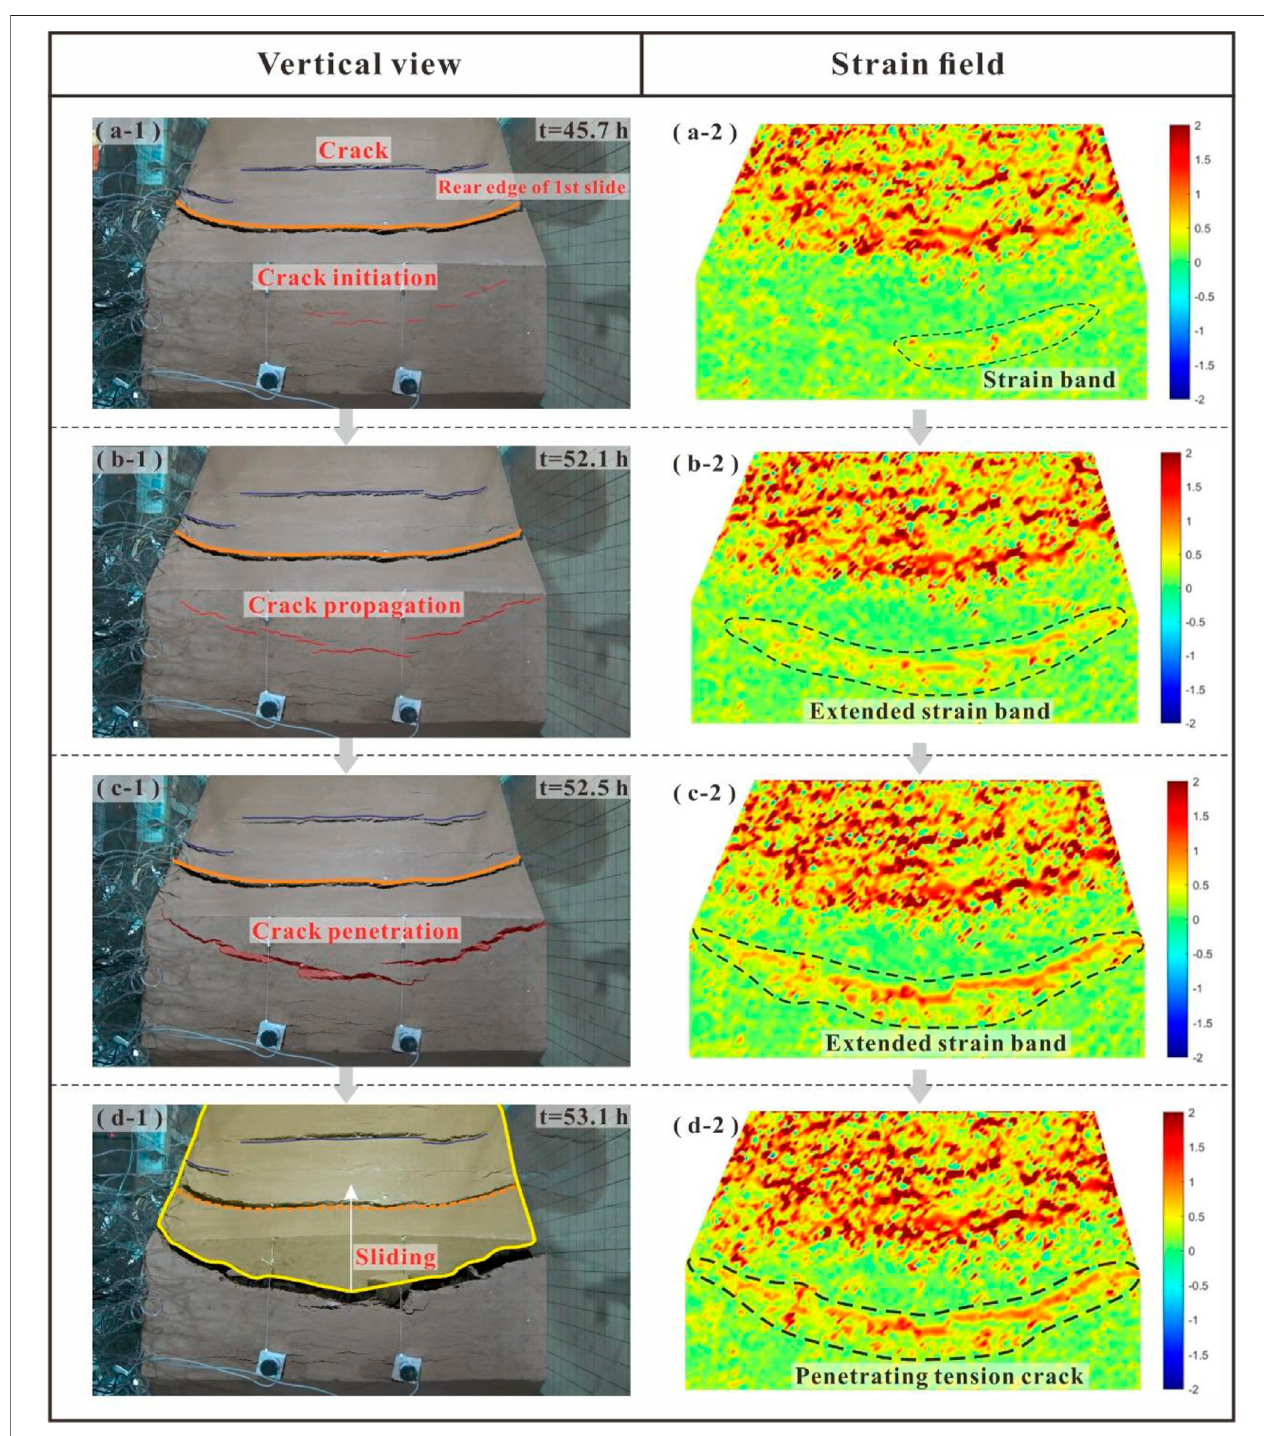
FIGURE 9 | Progressive process of the second slide from the vertical view. (A) Crack initiation, (B) crack propagation, (C) crack penetration, and (D) sliding.